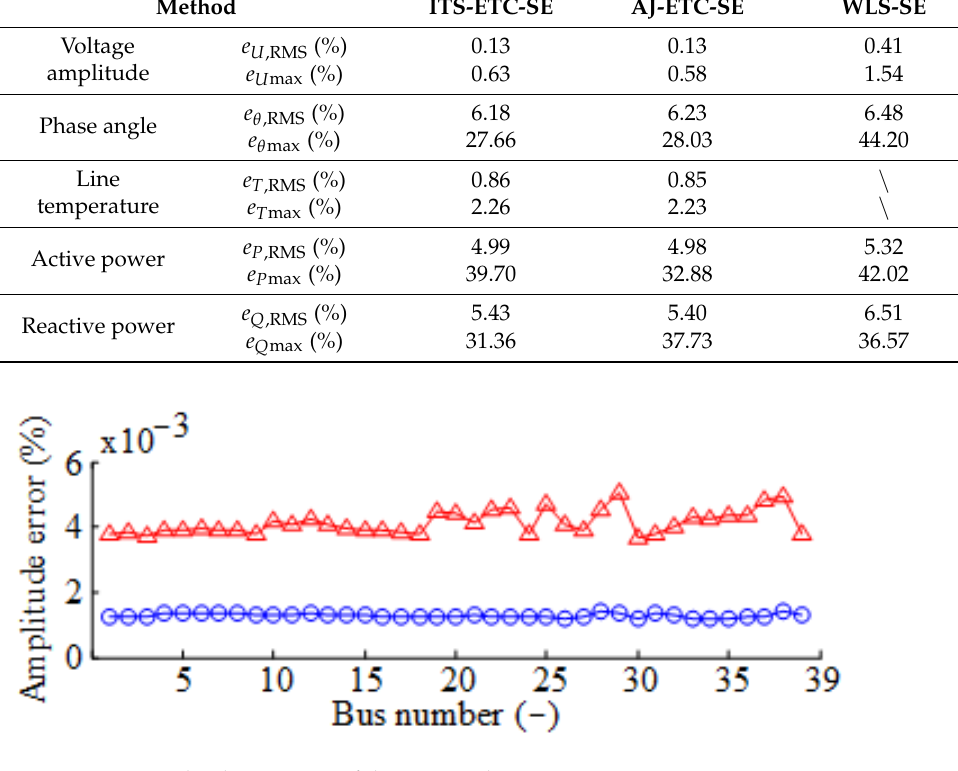
Figure 6. Averaged voltage errors of the IEEE 39-bus system.